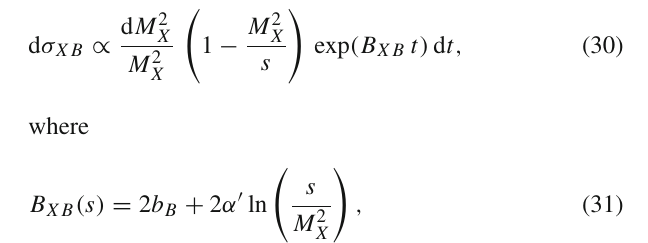
Fig. 5 Partial cross sections for pp, Δ 0 Σ 0 and Δ ++ Σ Δ 0 Σ 0 issimplyarescalingoftheppcase,exceptitgetsdifferentdiffrac- tive and non-diffractive contributions because pp implements explicit